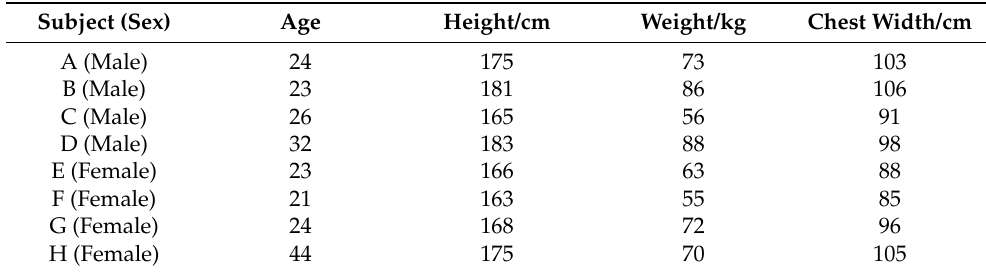
Table 1. Basic information of